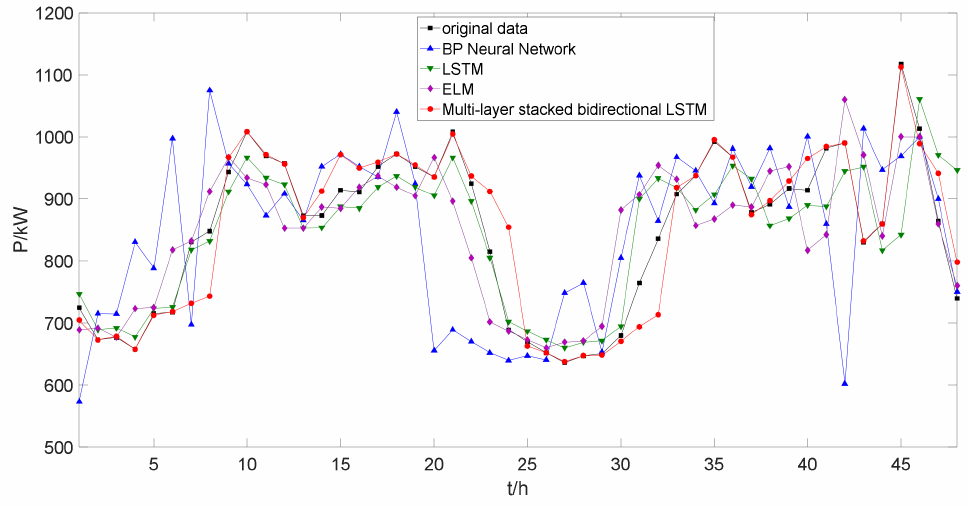
Figure 11. The load forecasting for a weekend with a 1 h sample training